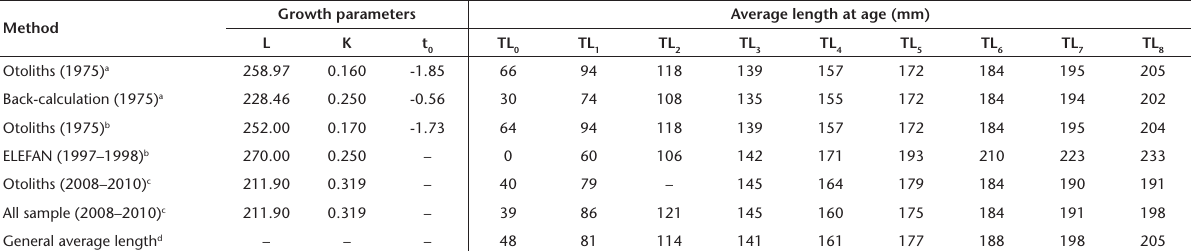
Table 3. Trachurus lathami: growth parameters estimated and average total length at age for the species in the Southeastern Brazilian Bight. Method